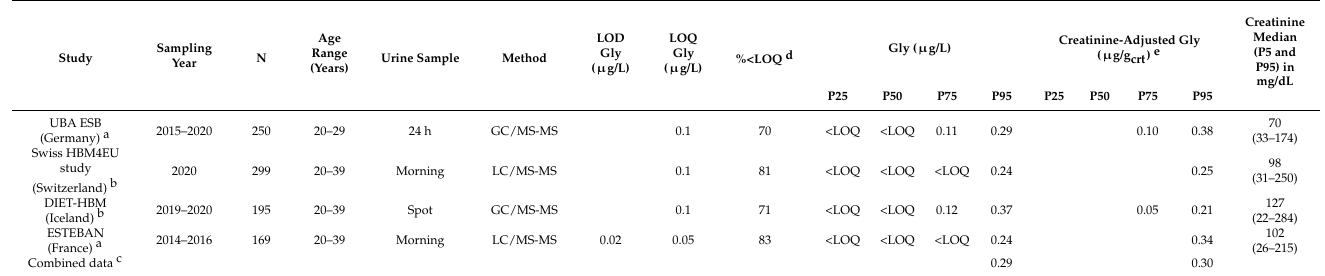
Table 1. Urinary glyphosate (Gly) concentrations in adults from HBM4EU-aligned